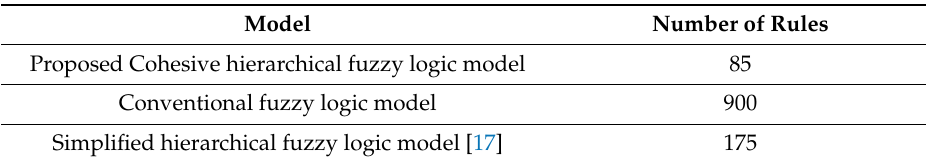
Table 1. Fuzzy logic with the number of rules.